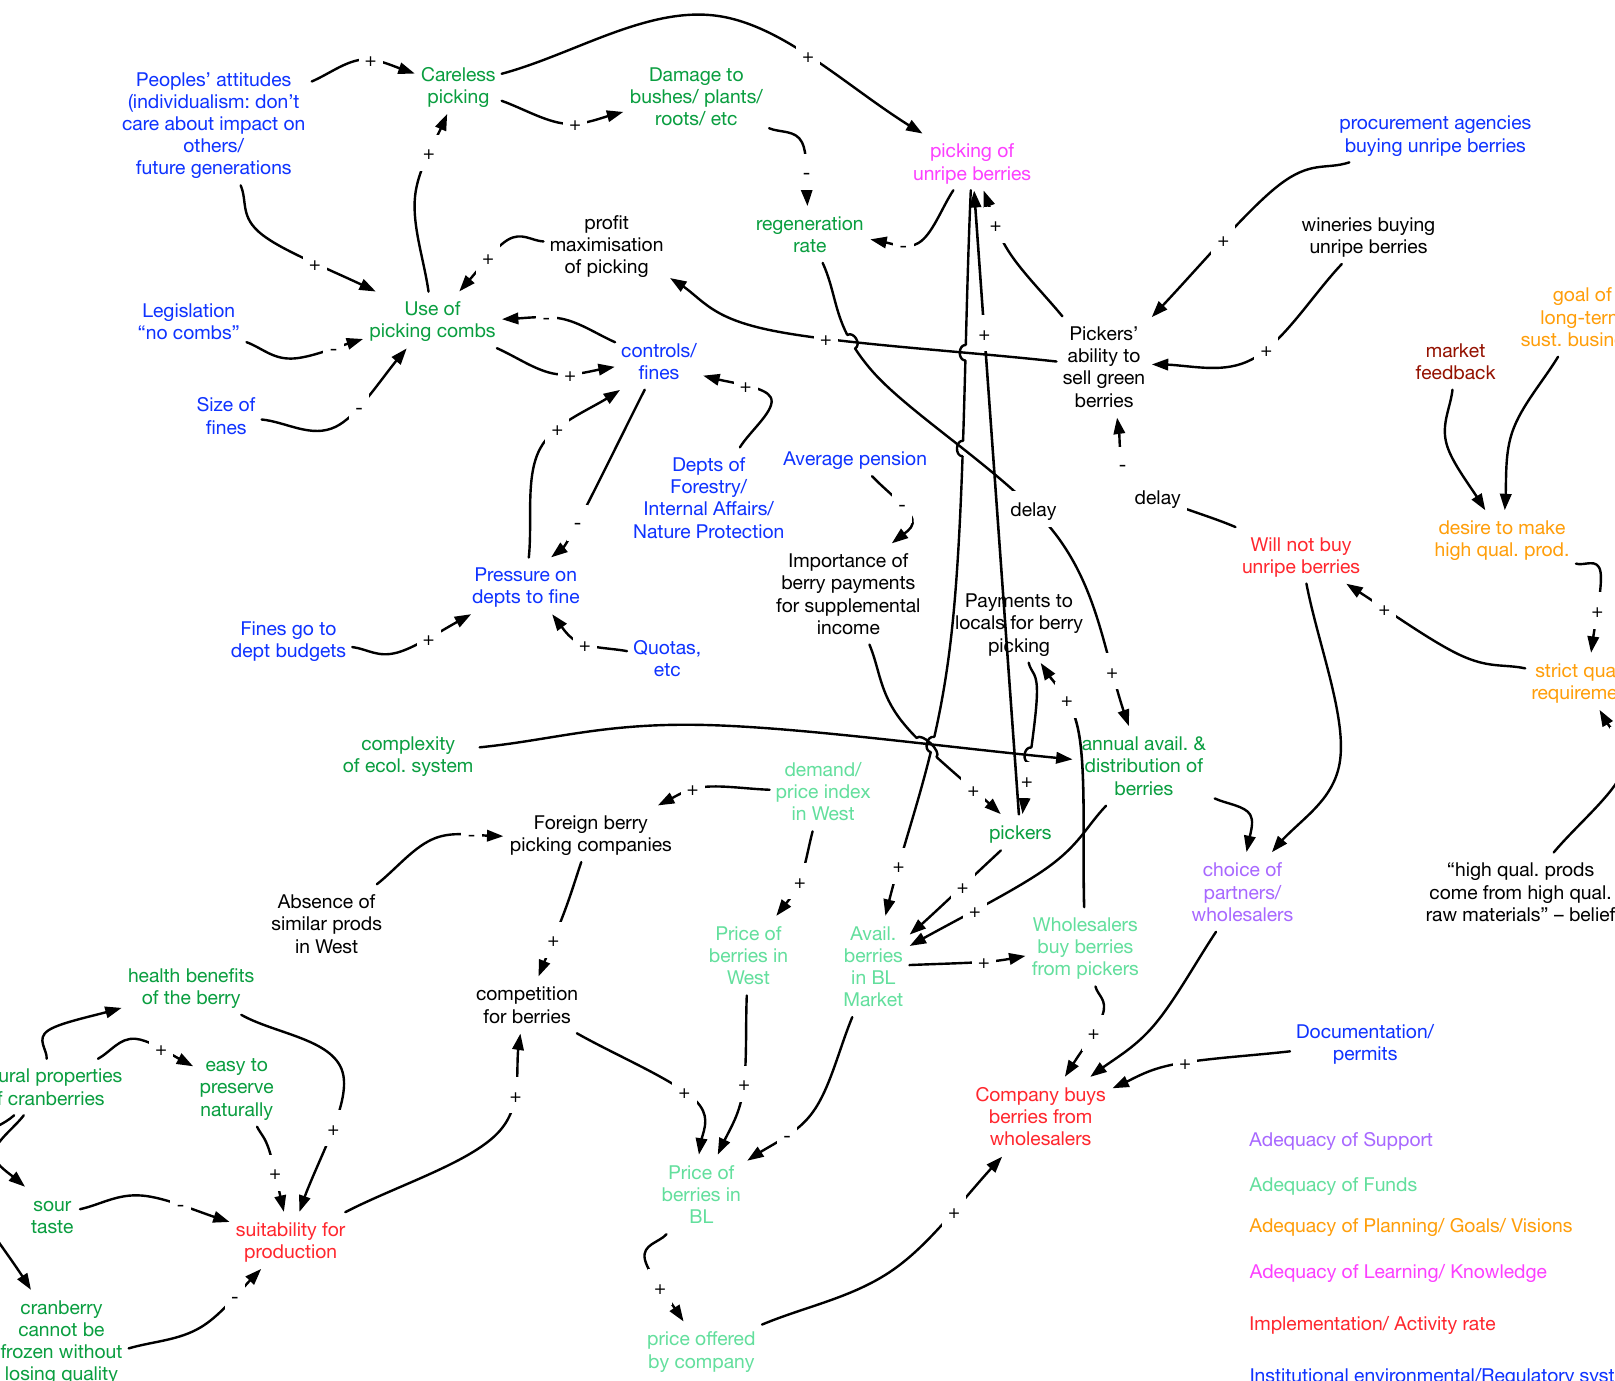
Figure A2:12. Case Berries, Theme: Ecological system, land